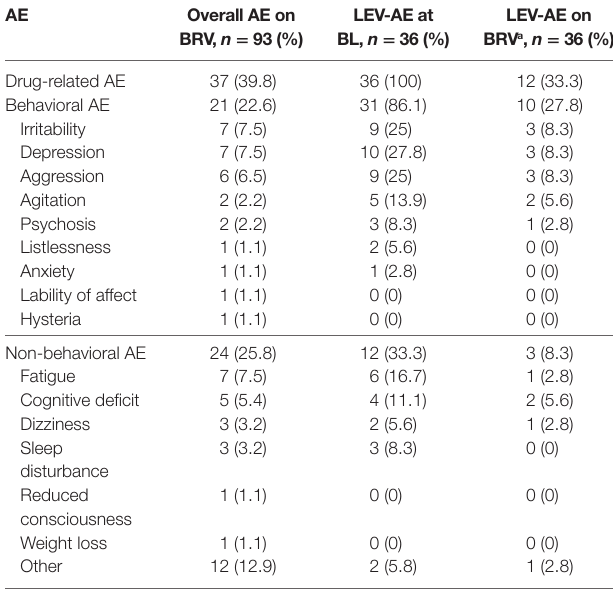
Multiple indication were possible. Note that some patients suffered multiple AE. Cognitive deficit was not objectified and mirrors subjective impressions by the patient. AE classified as “other” were non-severe NBAE, respectively, occurring in one patient only.